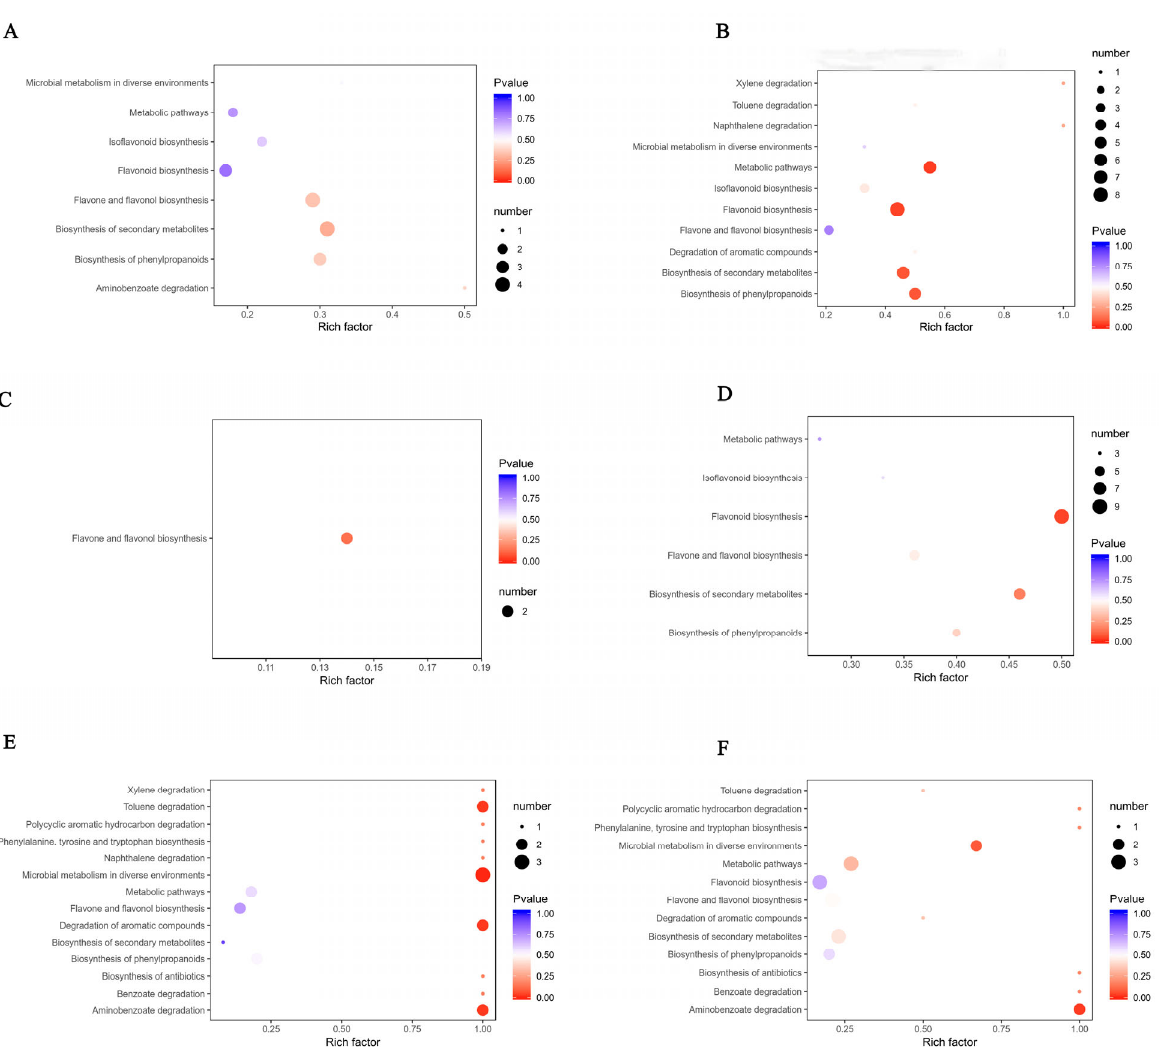
Figure 12. Enrichment results of the flavonoid differential metabolite KEGG pathway in each comparison group. ( A – F ) Pathway enrichment results of KEGG of the flavonoid differential metabolites of A1 vs. A6, A1 vs. A6, A1 vs. A2, A2 vs. A3, A3 vs. A4, A4 vs. A5, and A5 vs. A6, respectively. The abscissa is the ratio of the number of differentially expressed metabolites in the corresponding pathway to the total number of metabolites detected and annotated by the pathway, and the ordinate is the name of the KEGG metabolic pathway. The size of the midpoint represents the number of significantly different metabolites enriched in the corresponding